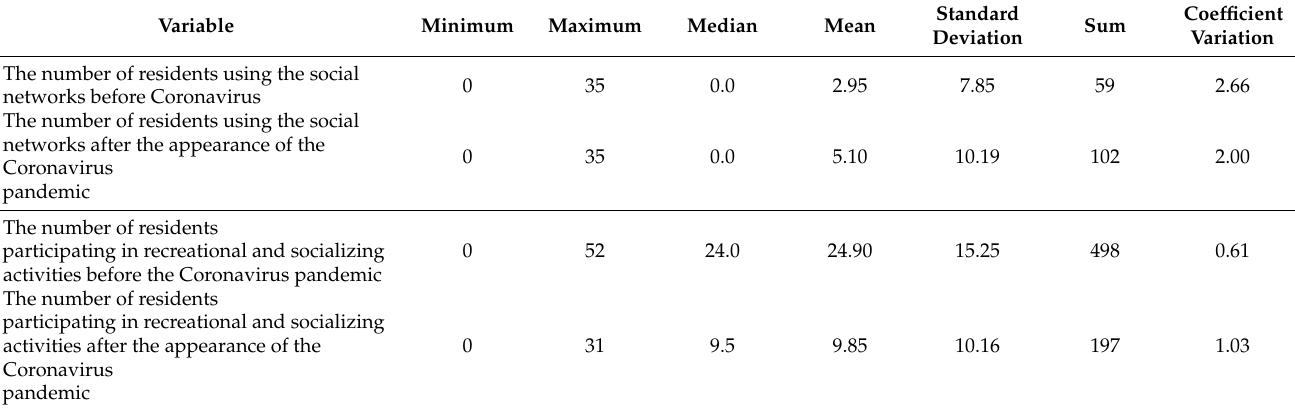
Table 1. The main number of residents using social networks and the number of residents participat- ing in recreational and socializing activity